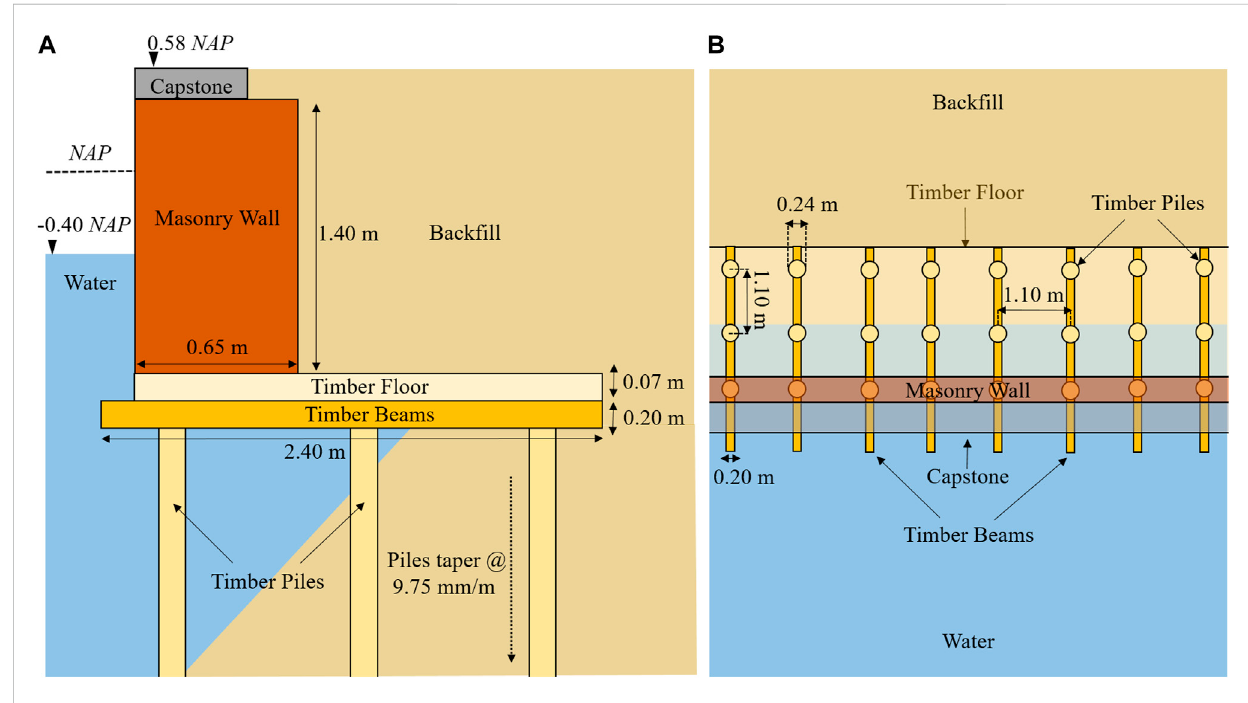
FIGURE 5 Geometry (original dimensions) of Marnixkade as de fi ned in the inspection report (NEBEST B.V., 2016): (A) transversal cross-section and (B) plan